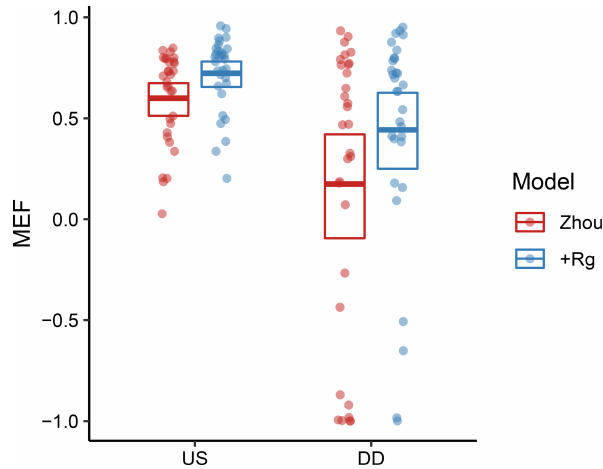
Figure 3. Model efficiency of the Zhou and + Rg models when eval- uated inside (DDevl) and outside (USevl; see Methods and Exper- imental design) water-limited dry-down events. The models were calibrated for all adequate site observations. The points indicate MEF for individual sites. The bold lines denote the mean, while the boxes indicate the bootstrapped 95% confidence intervals of the